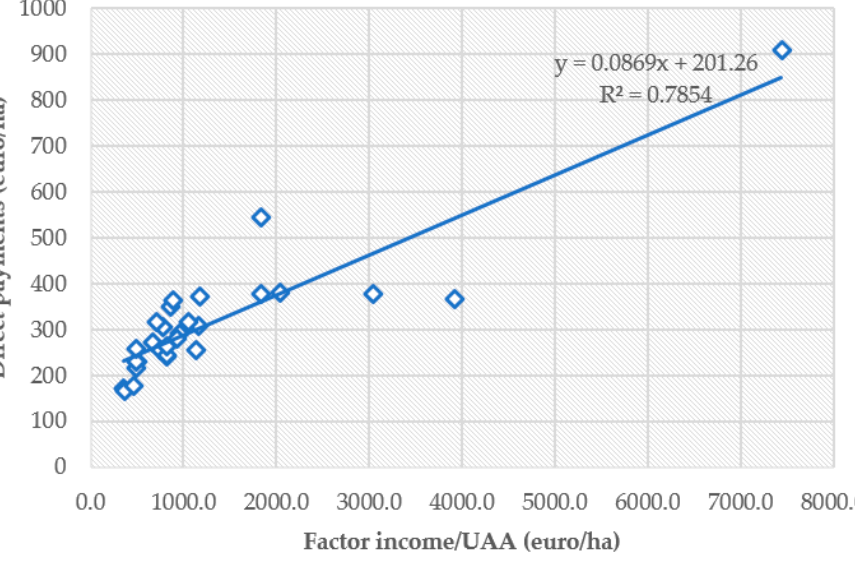
Figure 3. Correlation between factor income/UAA and direct payments (euro/ha). Having R 2 = 0.7854 determines a Pearson Correlation Coefficient R = √0.7854 = 0.88622 which means a pozitive correlation between the two variables, the 27 EU countries (represented by blue squares within the figure above) having a balanced distribution in relation to the trendline. In order to analyze one of the established hypotheses, the variables gross fixed capital formation (million euros) and total agricultural output (million euros) were taken into account to highlight the connection between them (Figure 4).